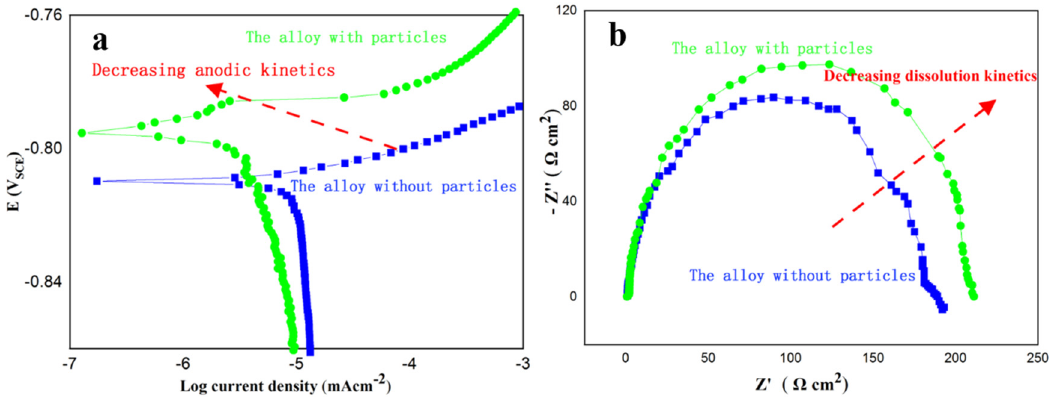
Figure 5. Electrochemical behavior of the alloys without and with particles. ( a ) Potentiodynamic polarization curve. ( b ) Nyquist plots from electrochemical impedance spectroscopy.